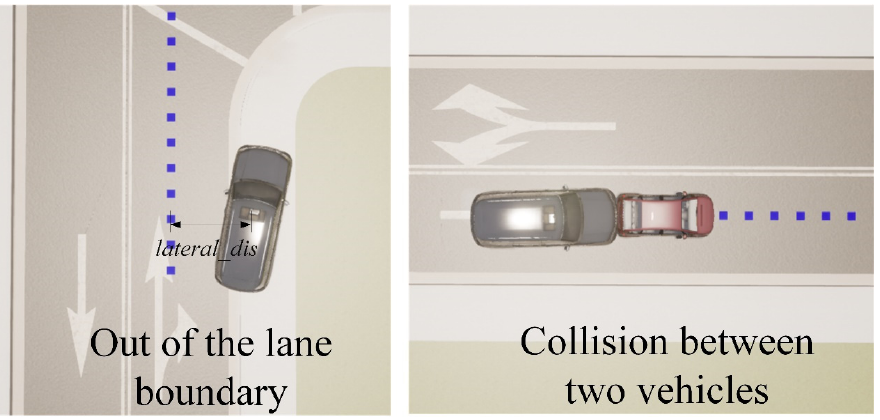
Figure 5. Two scenarios for exiting training